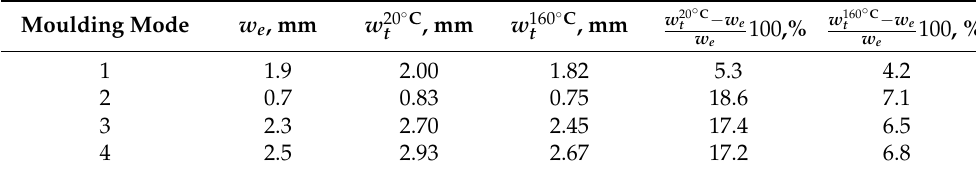
Table 6. Theoretical and experimental data processing.